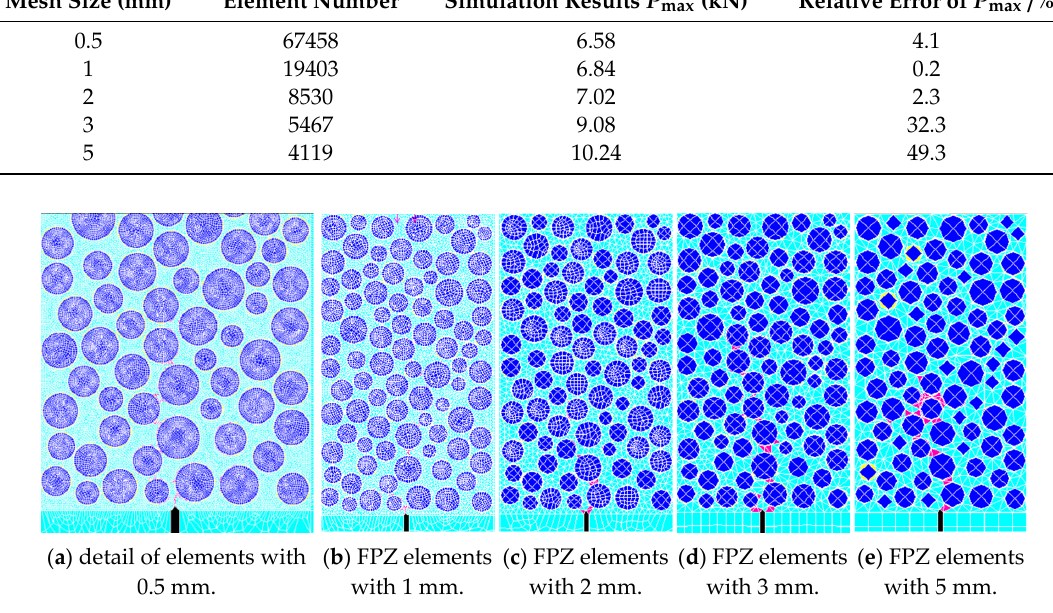
Figure 3. Diagram of cracks in fracture process zone (FPZ) of three-point bending (3-p-b) specimens with different mesh sizes (blue elements for coarse aggregates and red color for failure elements in interfacial transition zone (ITZ) and mortar).